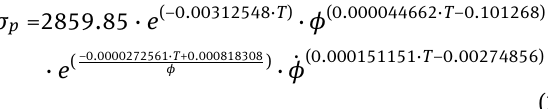
Each of the four heads of the 75 mm diameter preform is for a single arm of the shaft double crank. The next di- ameter, 48 mm, is for the main pin, crank pins and flanges with the diameters: 48 mm, 41 mm and 31 mm, are used for wheels timing gear and, possibly, auxiliary drives.